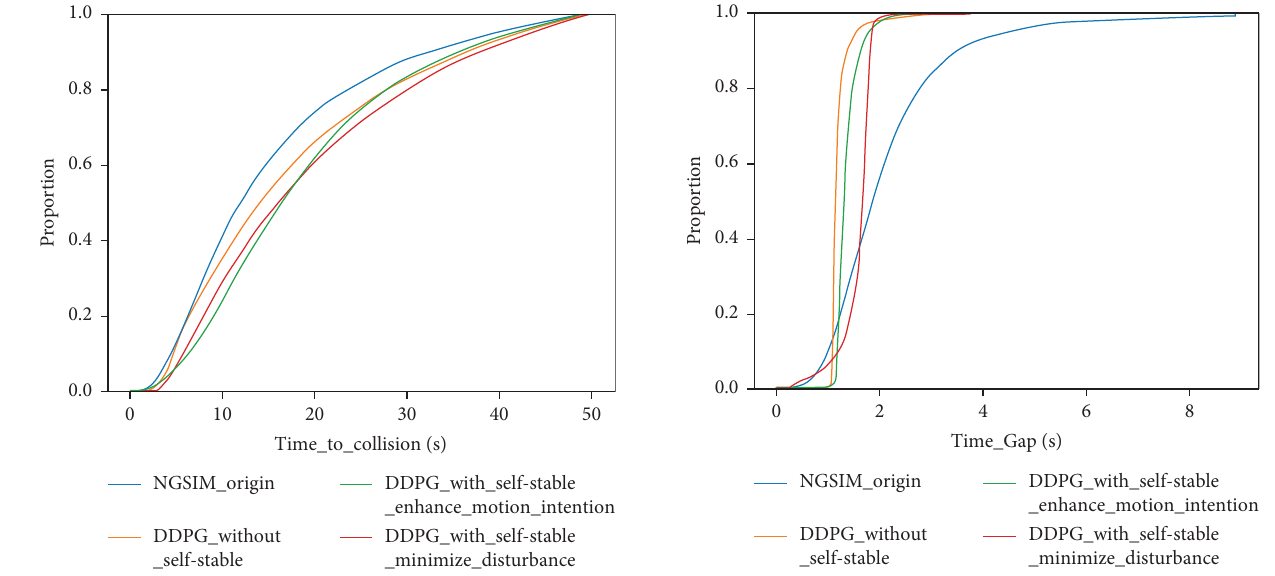
Figure 8: Cumulative distribution of TTC. Figure 9: Cumulative distribution of time